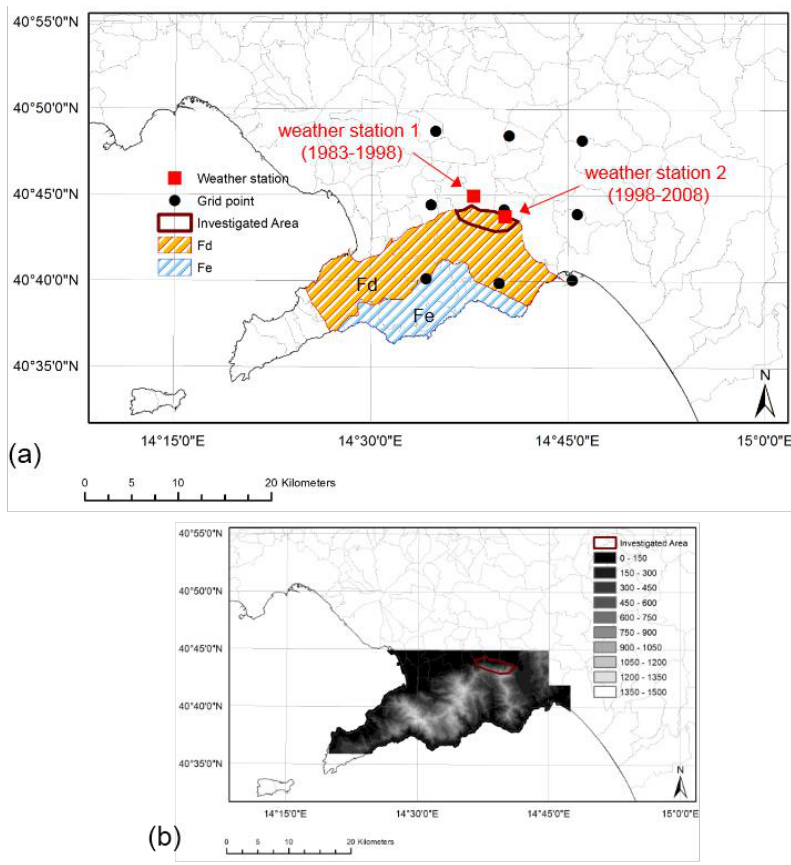
Figure 1. ( a ) Focus on part of Campania Region reporting the area recognized by Picarelli et al. [23] as susceptible to landslide events for Lattari Mts, the location of investigated area, the location of weather station (red dots) and the 3 × 3 grid adopted for climate simulation (black dots); ( b ) representation of DTM for Lattari